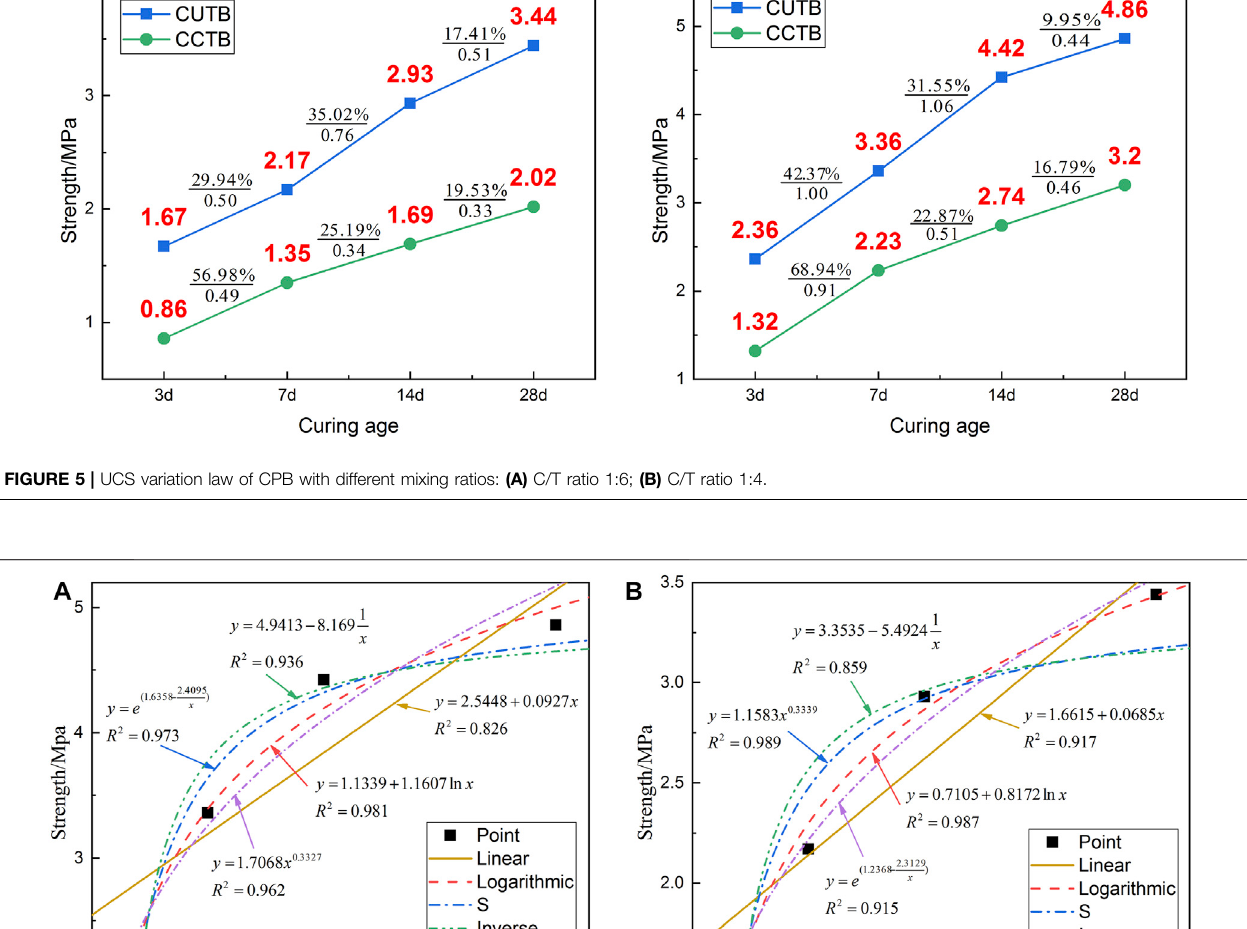
Frontiers in Materials |